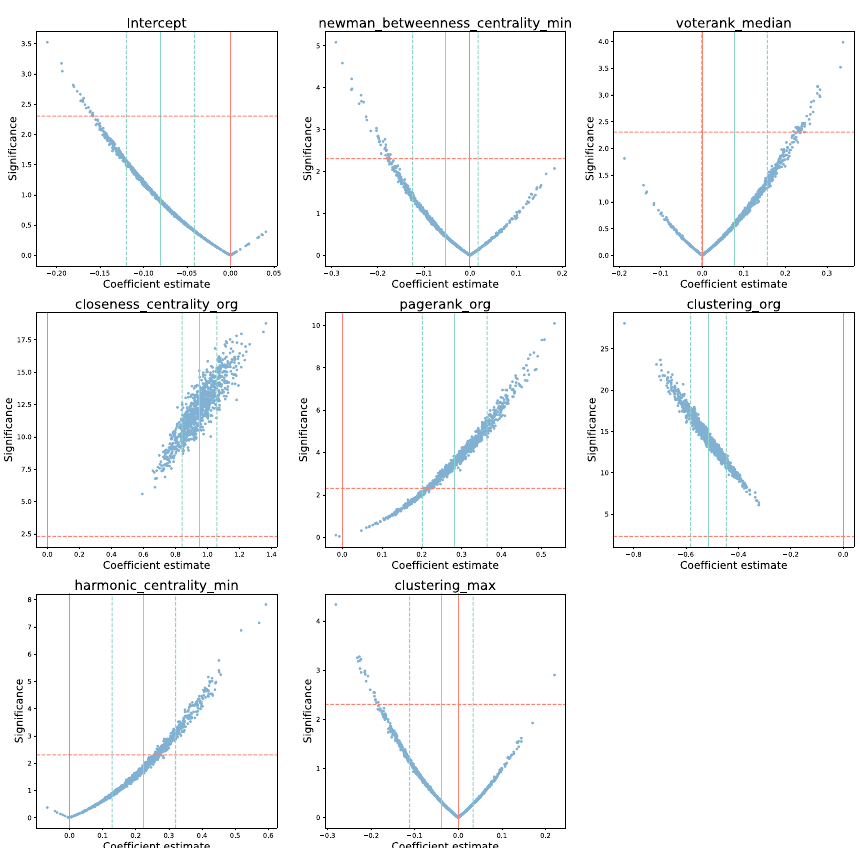
Fig. 5 Scatter plots of logistic regression coefficient estimates (horizontal) and significance (vertical; − log ( p - value )). The eight scatter plots correspond to the intercept (upper left) and the covariates selected in each of the seven covariate groups. Each point in a scatter plot represents one of 1000 fits run on data balanced by subsampling the majority low-regime class. Light blue solid lines mark averages across the fits, and light blue dashed lines are ± 1 standard deviations about them. Red vertical solid lines mark 0 coefficient values. Red horizontal dashed lines mark significance values associated to a p-value of 0.1